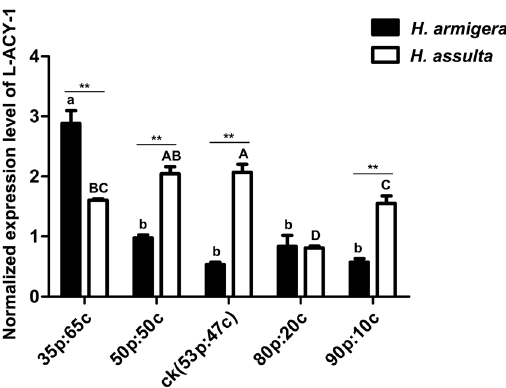
Figure 6. Effects of protein to digestible carbohydrate (P:C) ratios on the expression of L-ACY-1 in H. armigera and H. assulta . The data and error bars represent the means and standard deviations of three biological replicates of three technical repeats each. Values sharing the same letter [small case letters for H. armigera , capital letters for H. assulta ] are not significantly different at p < 0.05 (Tukey’s HSD tests). Significant differences at each of the five treatments between the two species are indicated by one star ( * p < 0.05, independent t-test) and two stars ( ** p < 0.01, independent t-test),